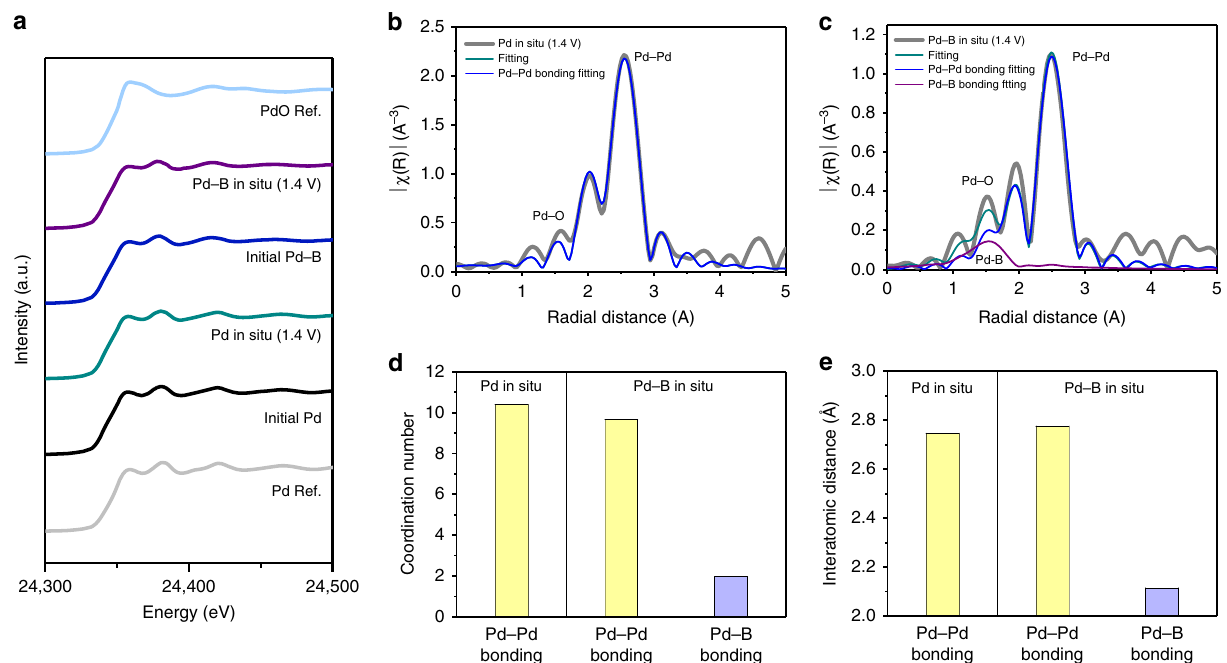
Fig. 3 Operando XAS of catalysts during DMC electroproduction. a Pd K-edge XAS for investigating the Pd and Pd – B catalysts at the potential of 1.4 V vs. Ag/AgCl. b , c Operando EXAFS of ( b ) Pd and ( c ) Pd – B to investigate the local atomic structure around the Pd atom with Pd – Pd and Pd – B fi tting. d , e EXAFS fi tting induced ( d ) coordination number and ( e ) interatomic distance comparison between Pd and Pd –